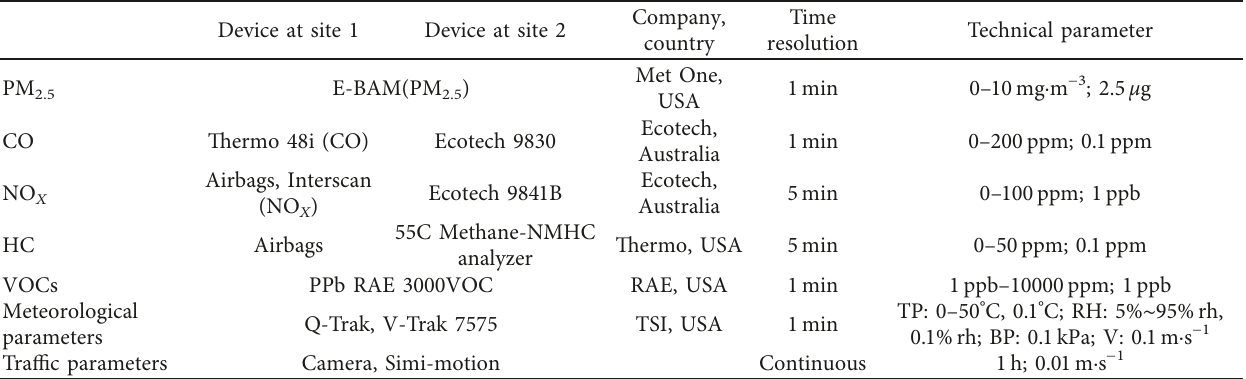
Figure 1: Sampling sites in the tunnel. The inlet sampling site was set 200m from the inlet, and the outlet sampling site was set 200 m from the outlet in the eastbound bore. Table 1: Measuring devices in the